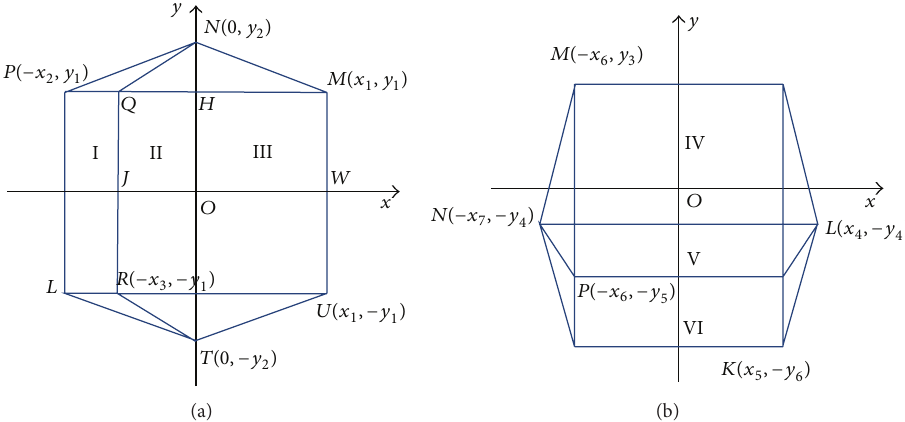
Figure 2: The transformation device: (a) the transformation along 𝑥 -axis and (b) the transformation along 𝑦 -axis.